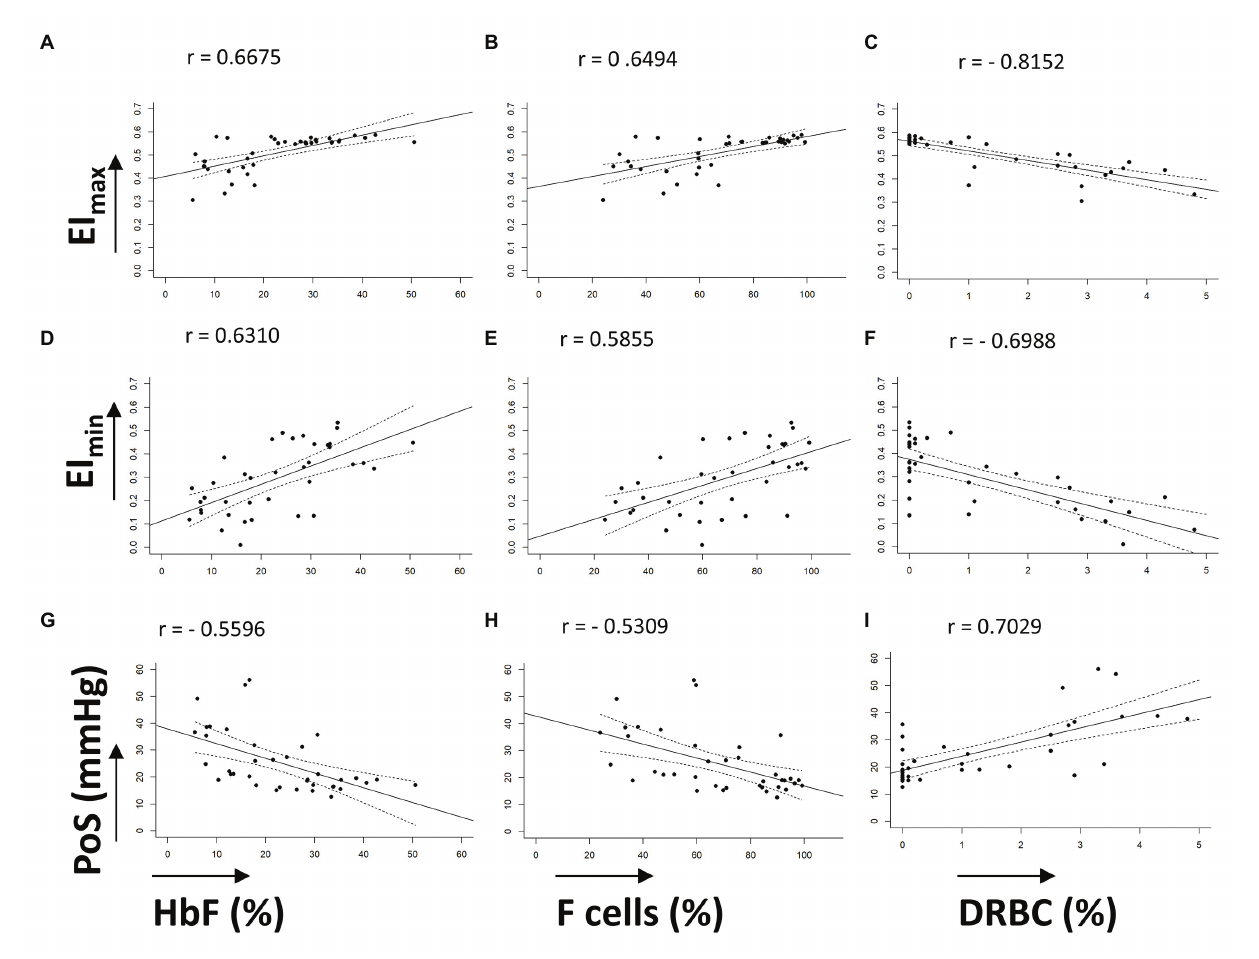
FIGURE 2 | Linear correlations of oxygenscan parameters with known biomarkers. (A–C) Linear correlations of EI max with %HbF, %F-cells, and %DRBCs, respectively. (D–F) Linear correlations of EI min with %HbF, %F-cells, and %DRBCs, respectively. (G–I) Linear correlations of PoS with %HbF, %F-cells, and %DRBCs, respectively. Dashed lines represent 95% CI. All correlations have p <